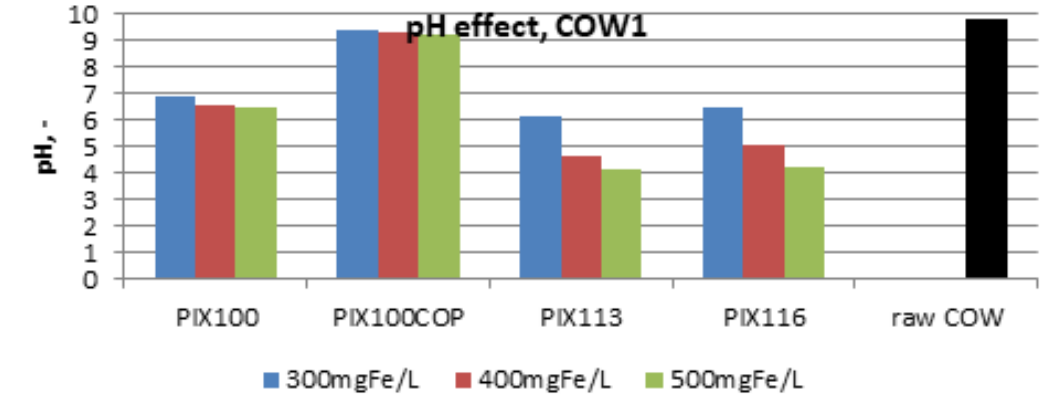
Figure 16: Effect of coagulant type and dose on pH of COW1.